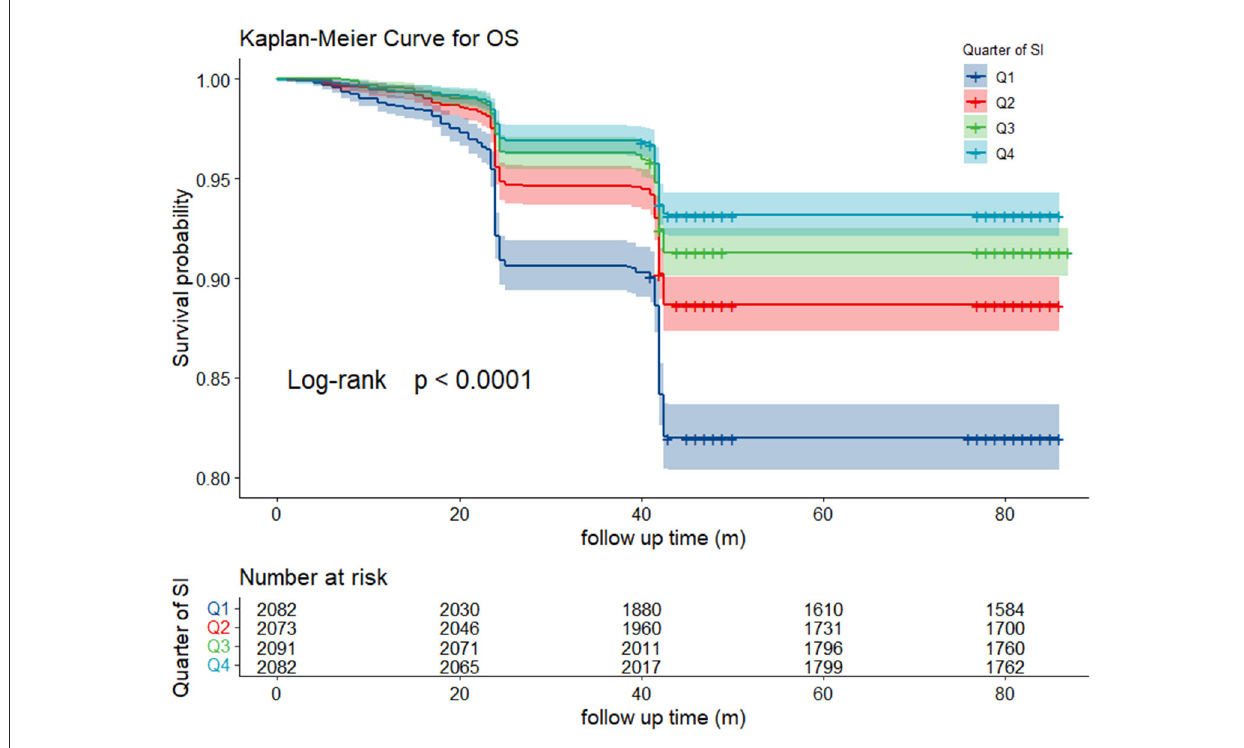
FIGURE2 Kaplan-Meier curve of survival rate among different SI level.